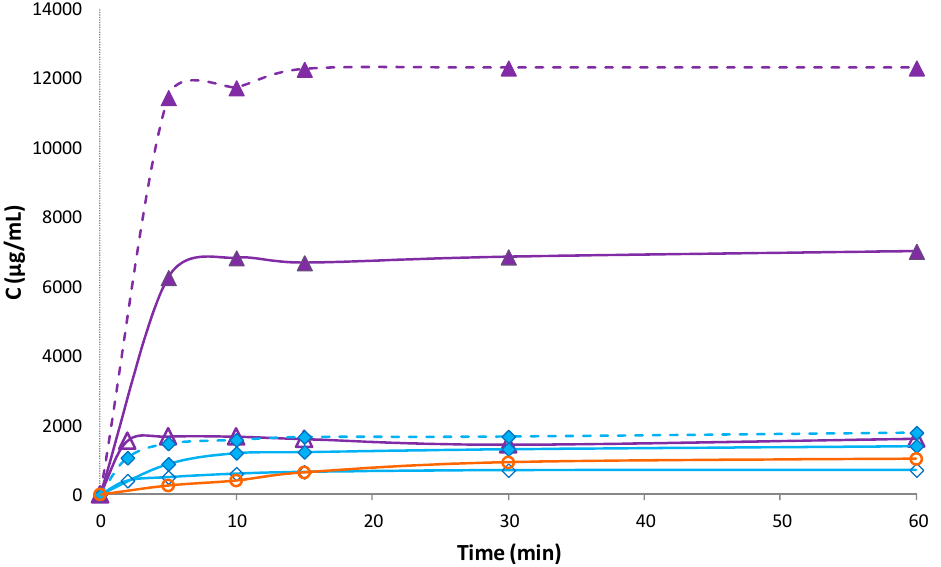
Figure 6. Dissolution profiles of HCT alone (o) and from its binary and ternary systems with RAMEB and SV: Physical mixtures (PM) (blue lines) with RAMEB ( (cid:7) ), SV ( ♦ ), and both ( (cid:7) dotted line) and co-evaporated (COE) products (violet lines) with RAMEB ( ▲ ), SV ( Δ ), and both ( ▲ dotted line). Each value represents the mean of 3 experiments.